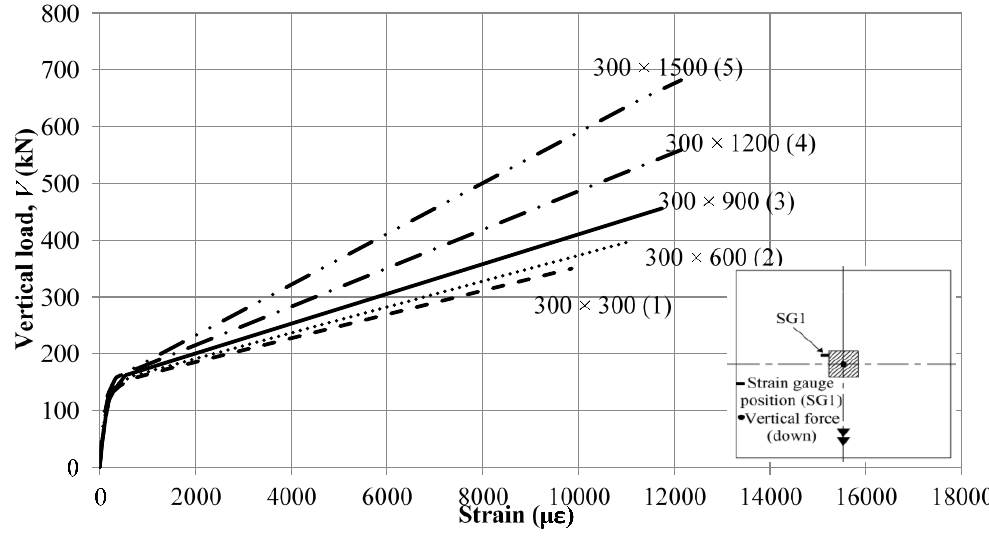
Figure 16. Load-strain relationship for the models with different column aspect ratios.